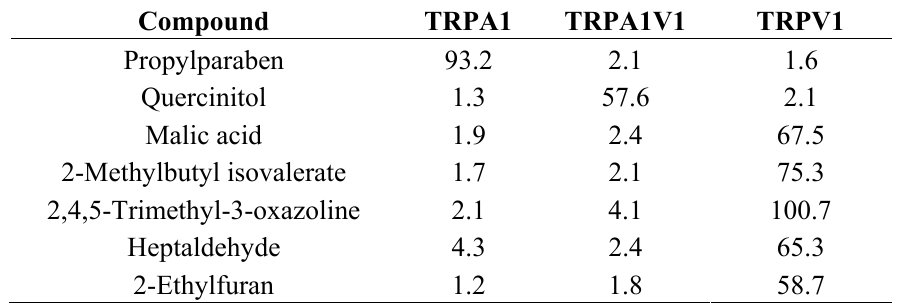
Table 2. Examples of compounds that activate either TRPA1 or TRPA1V1 or TRPV1.